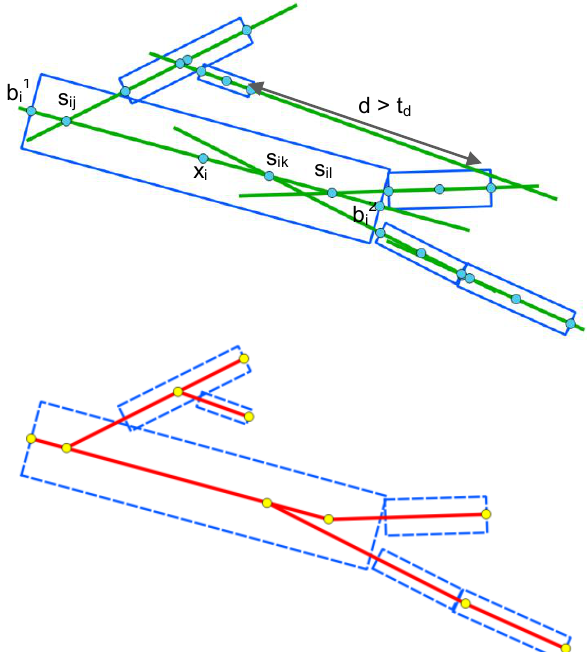
Figure 4. From the geometry of the rectangles different points are derived (top) and a final graph is constructed